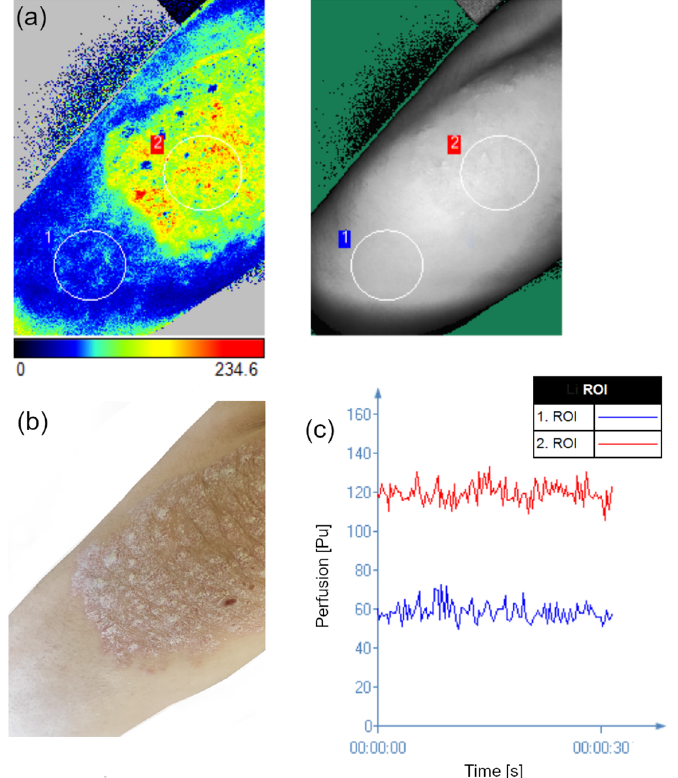
Figure 2. LASCA perfusion map representing the skin without psoriatic lesion (ROI 1) and psoriatic lesion (ROI 2) ( a ). Clinical photography corresponding to the measured area ( b) time evolution of the perfusion in the two ROI shown in image a ( c ).